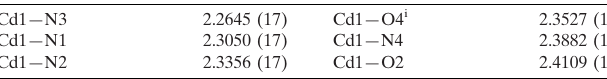
Selected bond lengths (A˚ ).